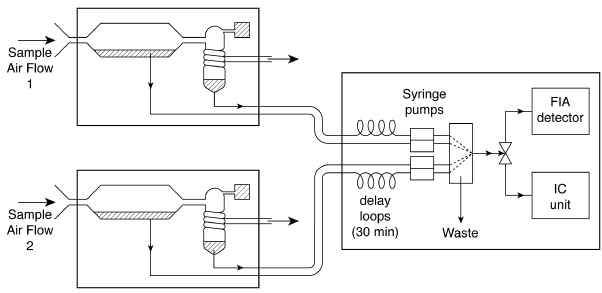
Fig. 1. Simplified scheme of the GRAEGOR